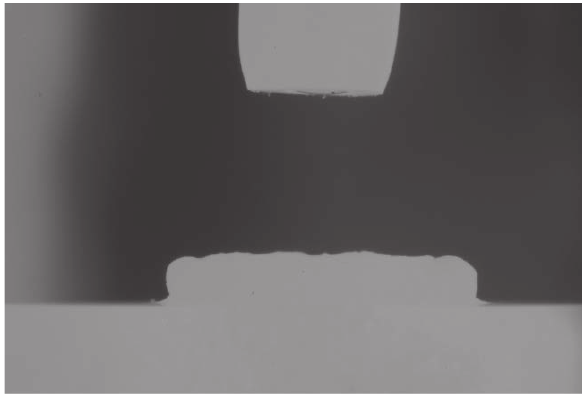
Fig. 5: Picture of the FeCr23 (10 min) droplet in experiment 9